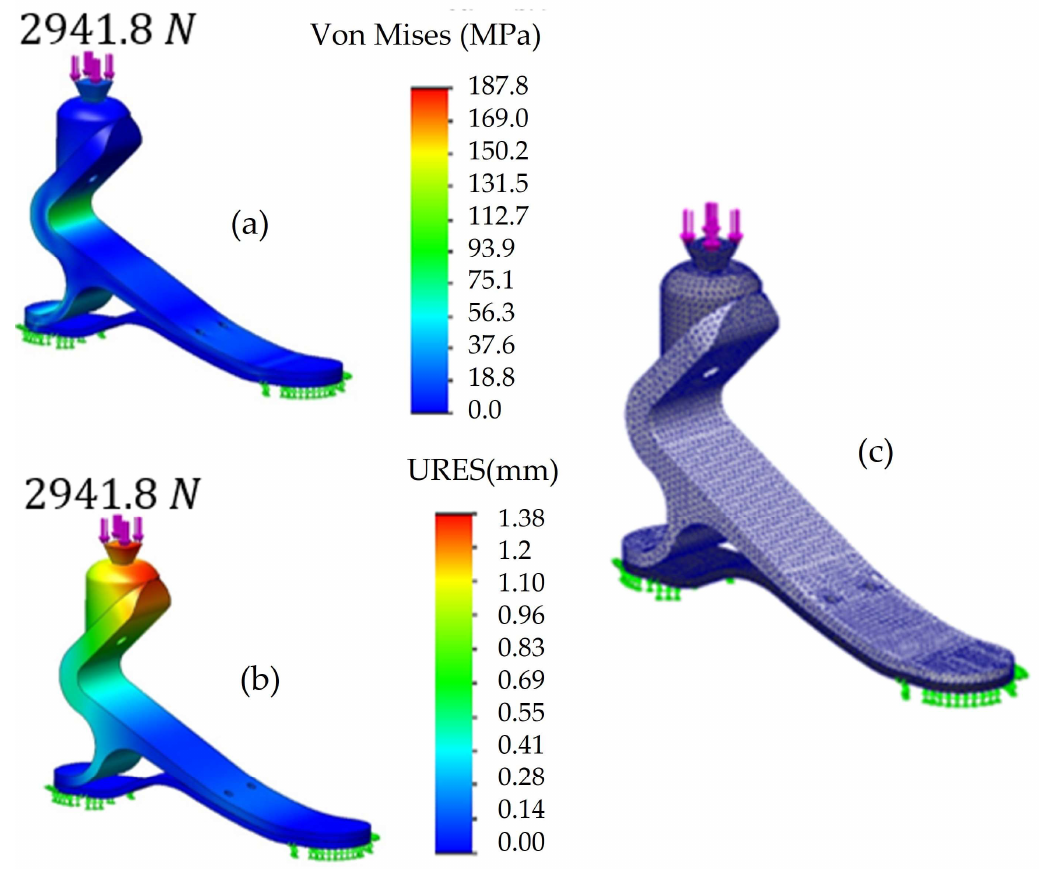
Figure 13. Static analysis for the prosthetic foot: ( a ) von Mises stress; ( b ) displacement; ( c ) mesh details.